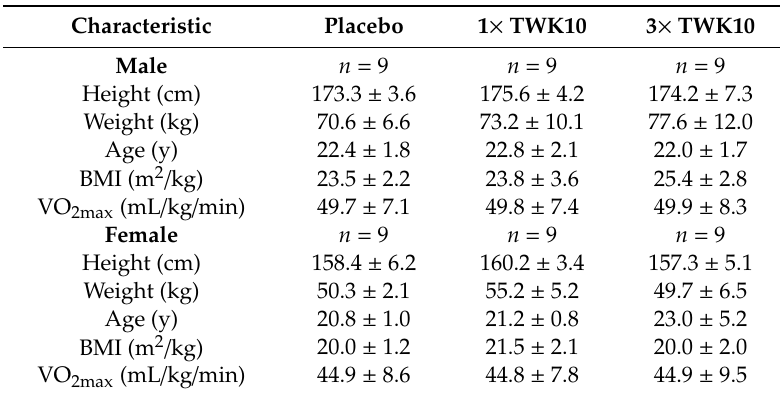
Table 1. Background data of the